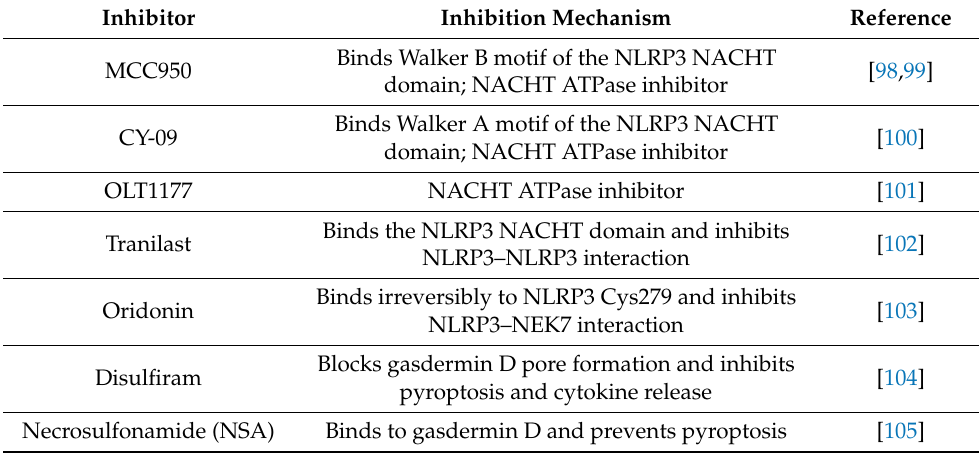
Table 2. NLRP3 inhibitors and their